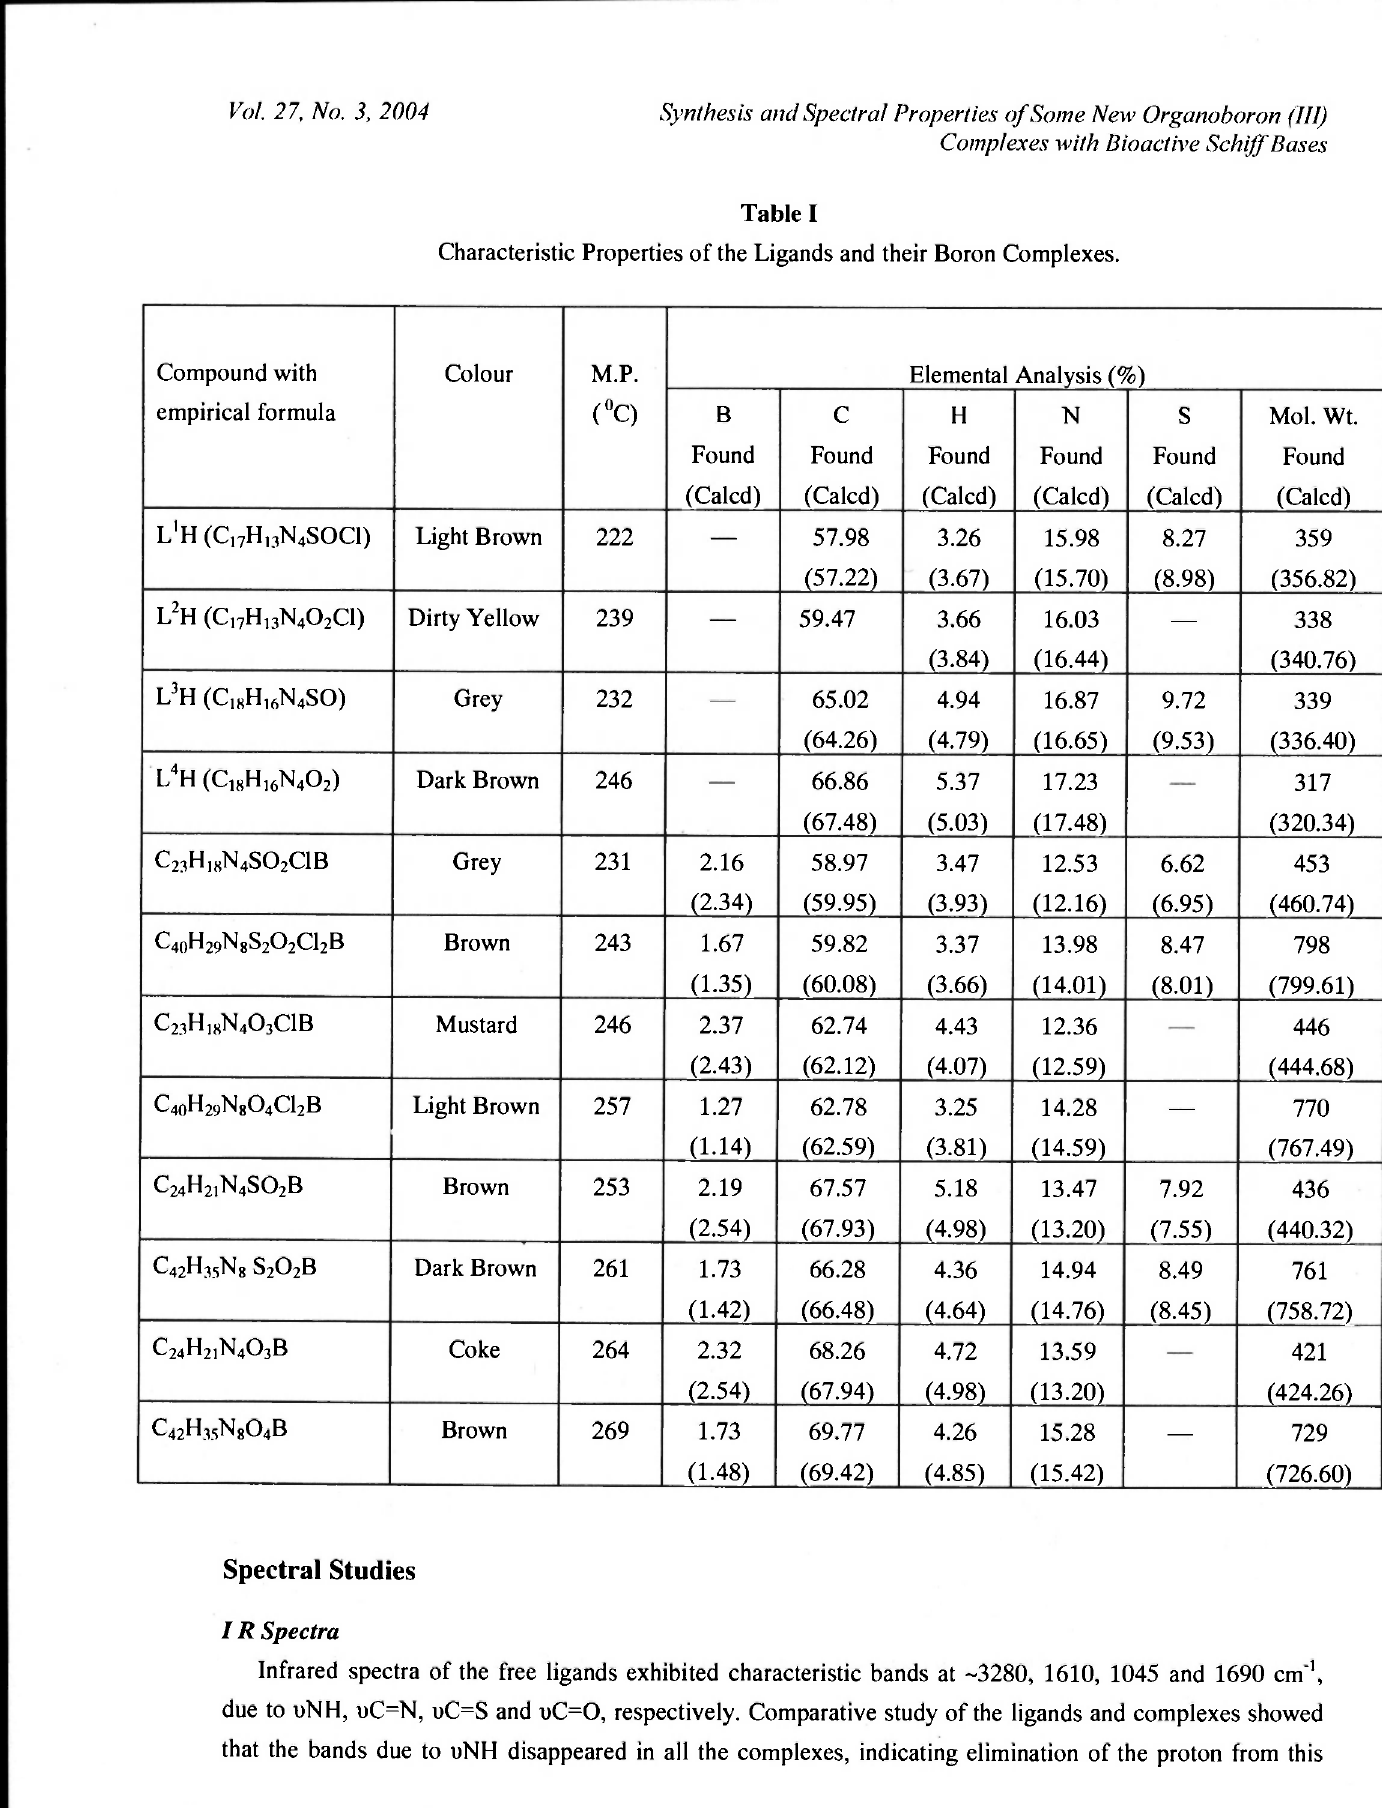
Characteristic Properties of the Ligands and their Boron